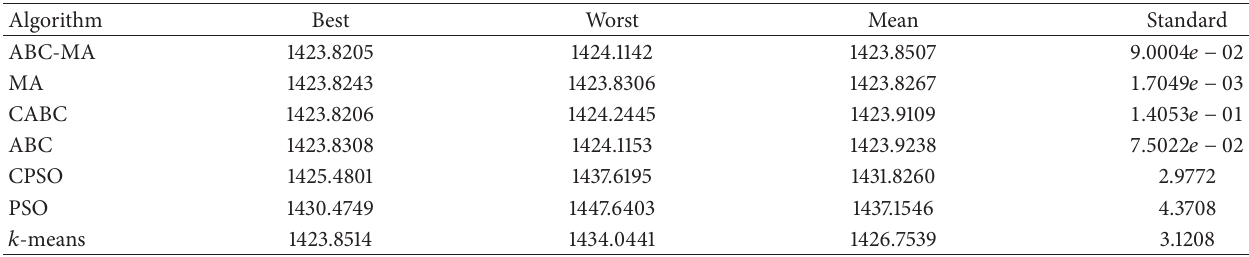
Table 10: Results obtained by the algorithms for 20 different runs on balance scale